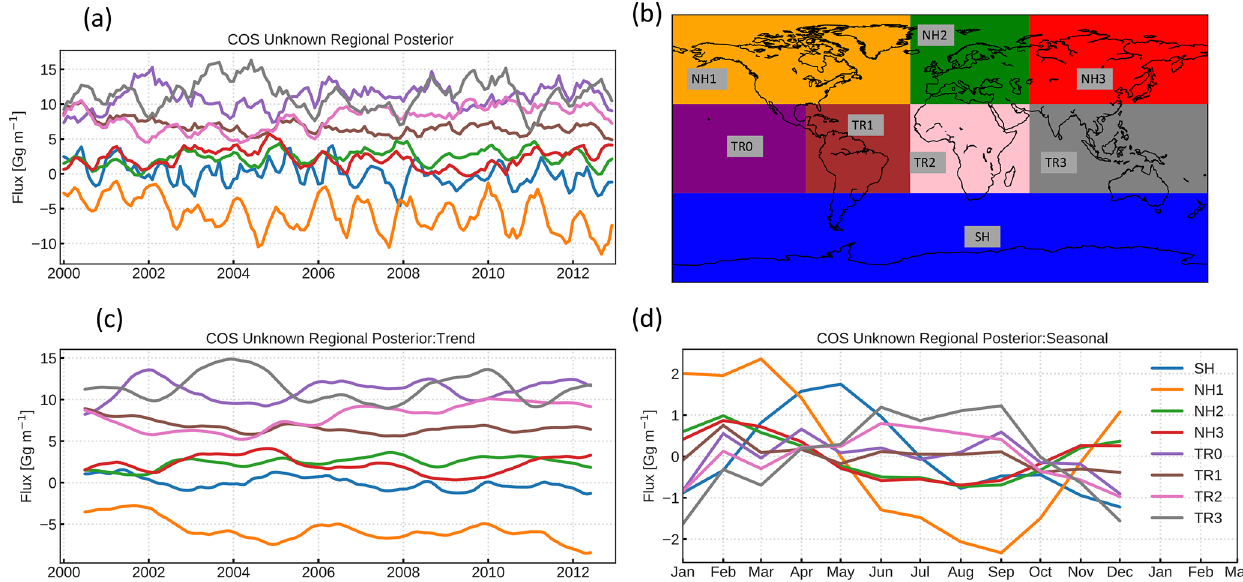
Figure 6. Regional analysis of multi-year optimized COS fluxes of inversion S u : (a) posterior flux per region, (b) regions over which the posterior flux is analysed, (c) trend in the decomposed signal and (d) seasonal signal in the decomposed signal. Note that region colours in (b) are used in (a) , (c) and (d) .